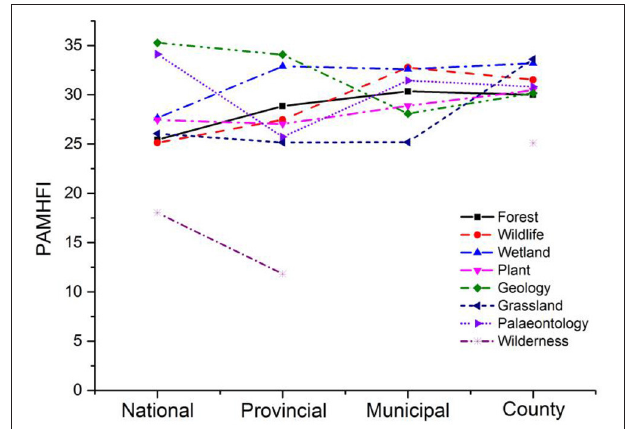
FIGURE 4 | Mean PAMHFI for each PA category at each governance